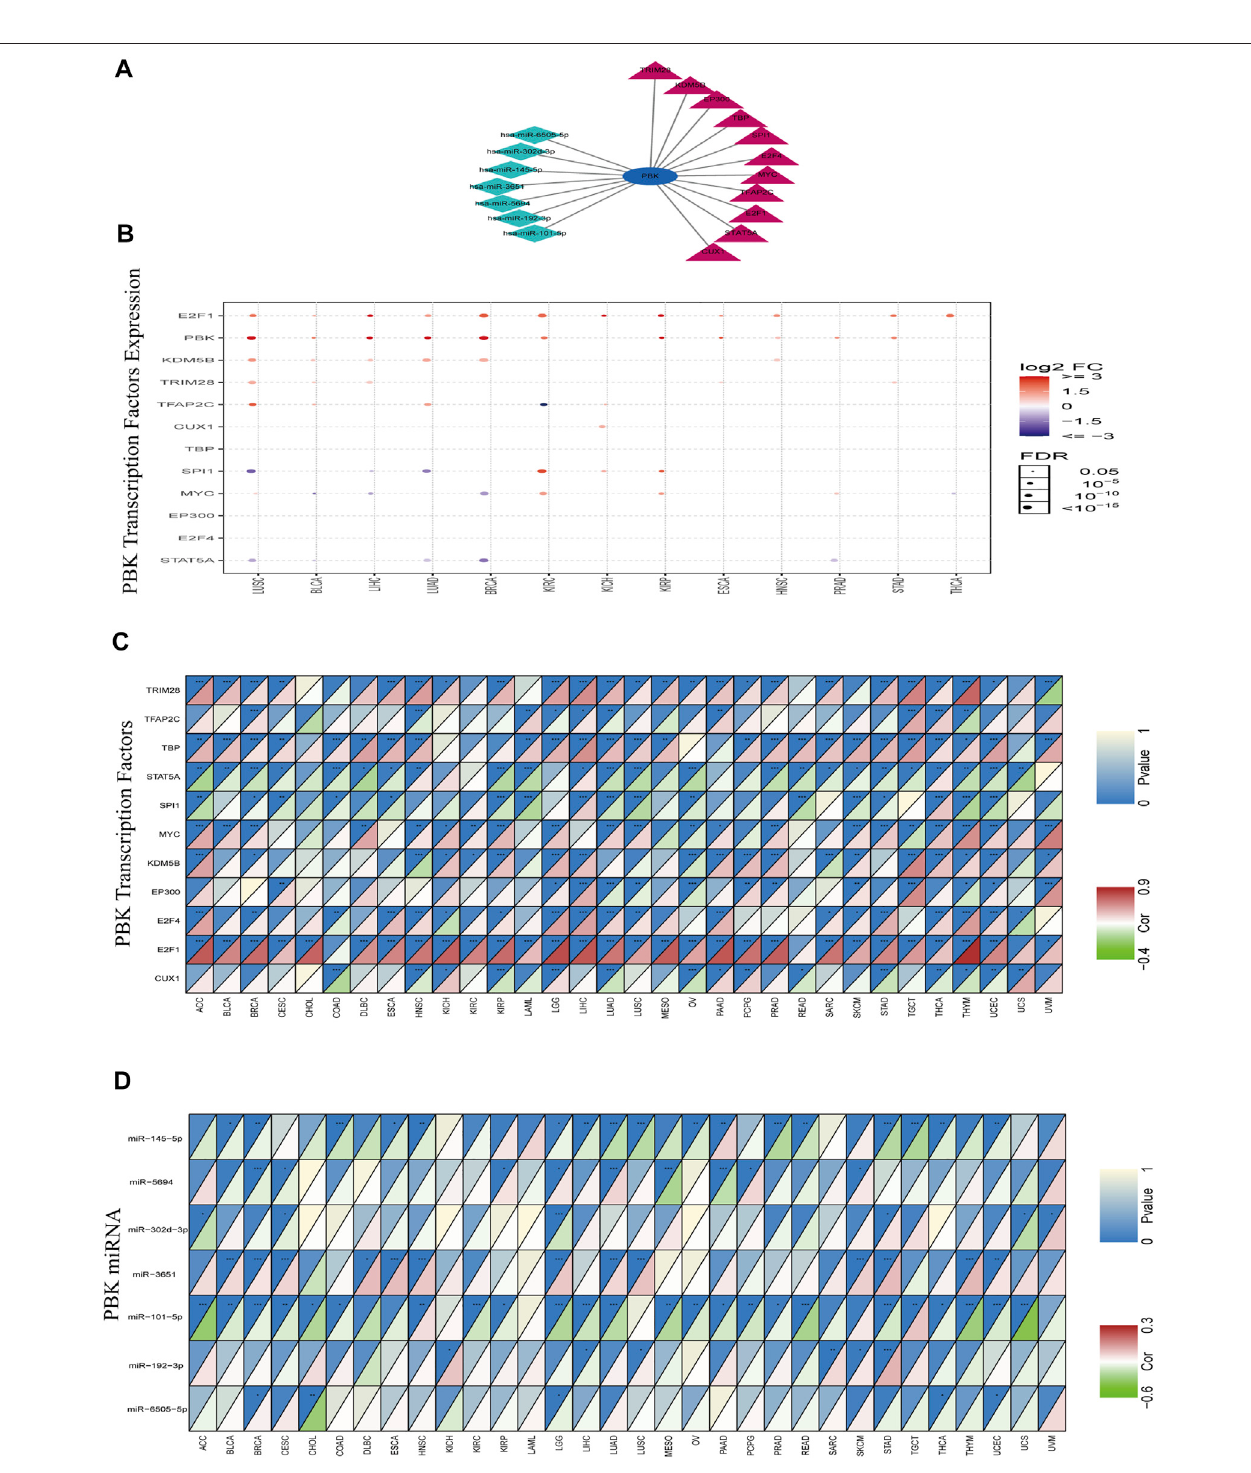
FIGURE 4 | TF and miRNA regulatory networks. (A) TF and miRNA network. (B) Expression of TFs in 14 cancers. Red and blue dots indicate increased and decreased expression, respectively, in cancers vs normal tissues. (C, D) Heatmap of TFs (C) and miRNAs (D) altered in 32 cancers. Red means TFs or miRNAs is positively correlated with PBK expression, green means TFs or miRNAs is negatively correlated with PBK expression.